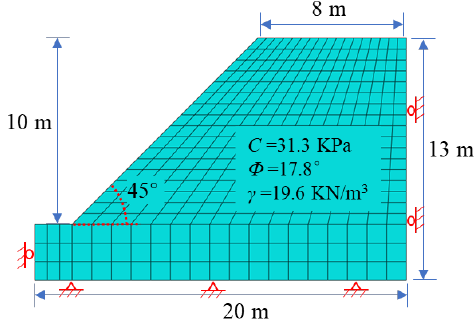
Figure 2. Numerical model of slope.